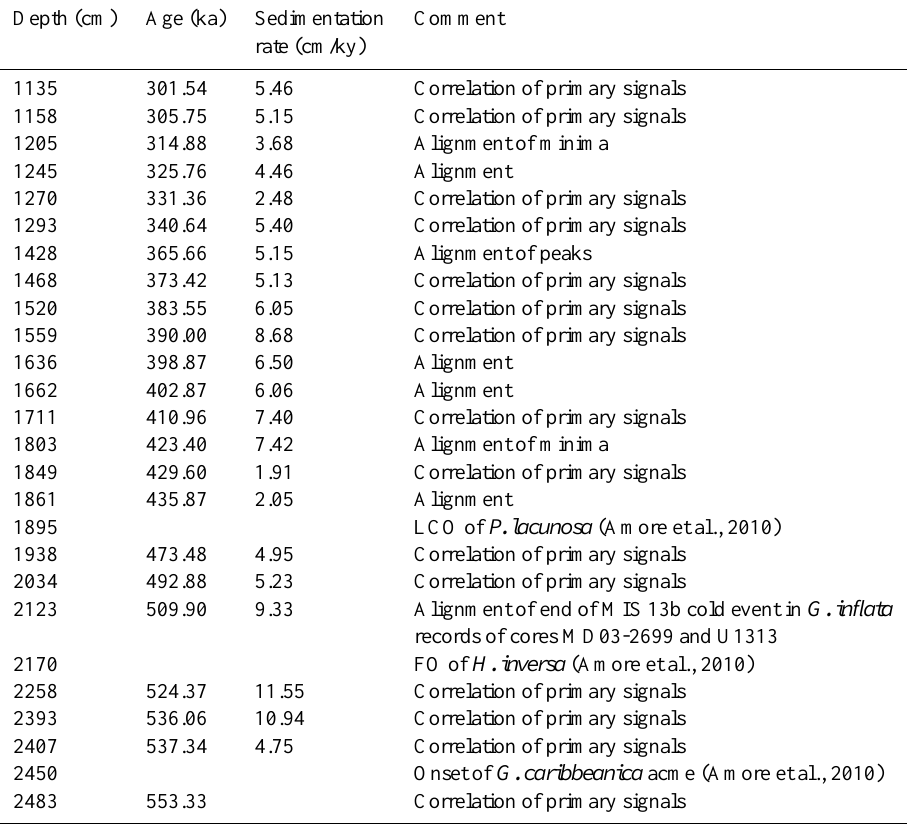
Table 2. Age model, sedimentation rates and relevant nannofossil events for core MD03-2699. Depth